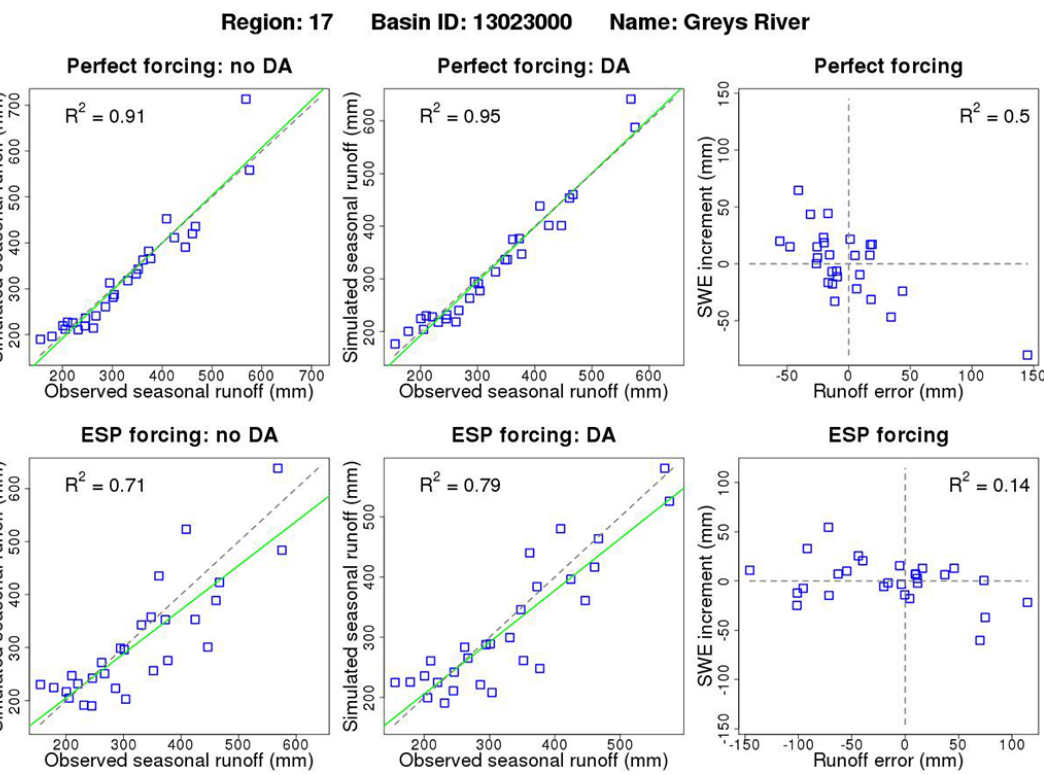
Figure 11. Scatterplots for seasonal runoff and SWE on the DA date for the Greys River. Black dashed diagonal lines indicate the 1 : 1 line, while the green lines indicate linear regression fits to data. Perfect forcing results are shown in the top row, while ESP results are in the bottom